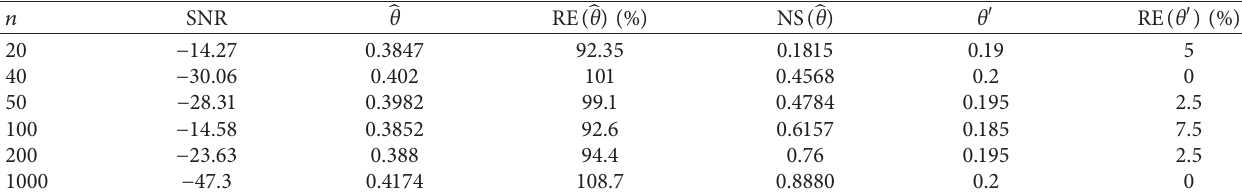
Table 4: Calibration performance for different sample sizes.